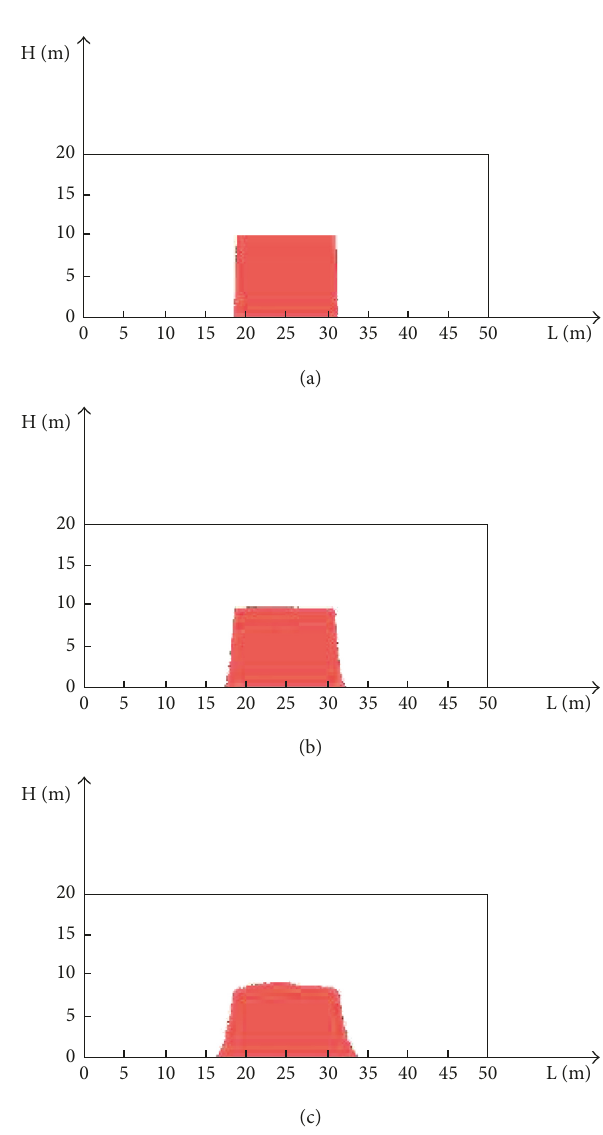
Figure 2: Simulated propagation of the viscous material flow.